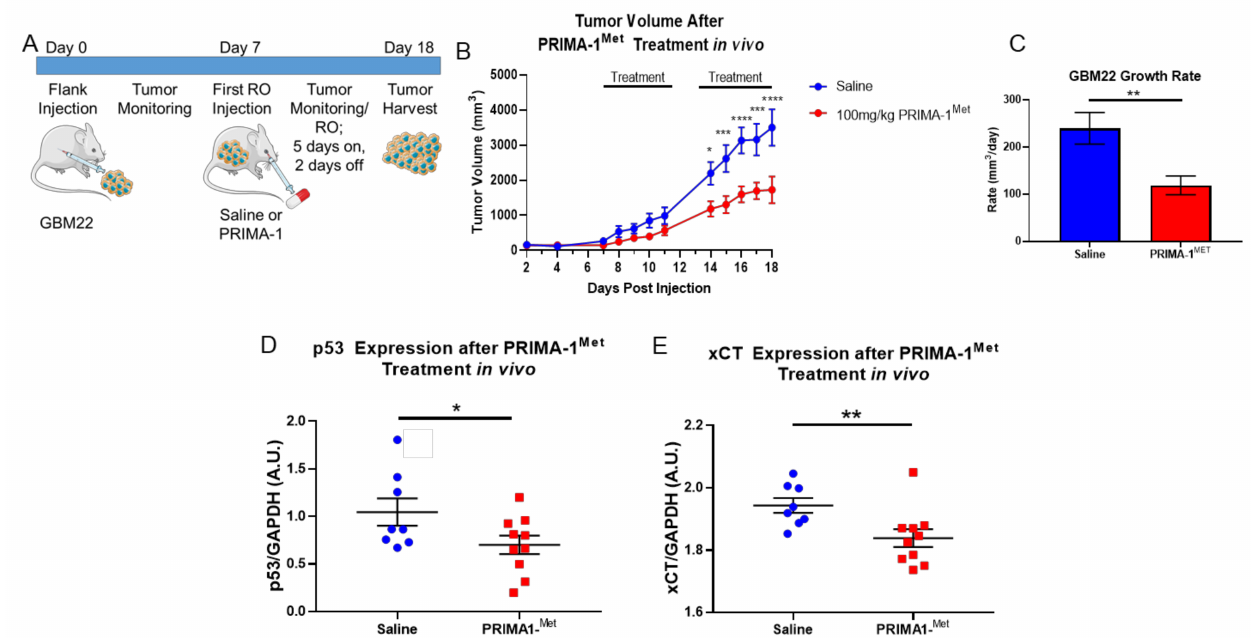
Figure 5. Mutant p53 chemical restoration mitigates SXC-mediated glioma biology in vivo. ( A ) A schematic representing the tumor implantation and dosing regimen for our PRIMA-1 Met in vivo flank experiment. There were 8–10 animals per dosing group. ( B ) Tumor volumes were measured in animals during routine animal health monitoring. Tumor growth decreased in the PRIMA-1 Met -treated animals compared to saline controls. A two-way ANOVA with Šid á k’s multiple comparisons test was performed. Error bars represent S.E.M. **** p < 0.0001, *** p < 0.001, * p < 0.05. ( C ) The rate of tumor growth from ( B ) plotted for both treatment groups also shows that the growth rate decreased in the PRIMA-1 Met -treated animals compared to saline controls. An unpaired t-test was performed. Error bars represent the mean ± S.E.M. ** p < 0.005 ( D , E ) Western blot analysis of harvested tumor tissue was performed after the conclusion of the dosing experiment. Both p53 and xCT protein levels were decreased in PRIMA-1 Met -treated animals compared to saline controls. An unpaired, one-tailed t-test was performed. ** p < 0.01, * p <